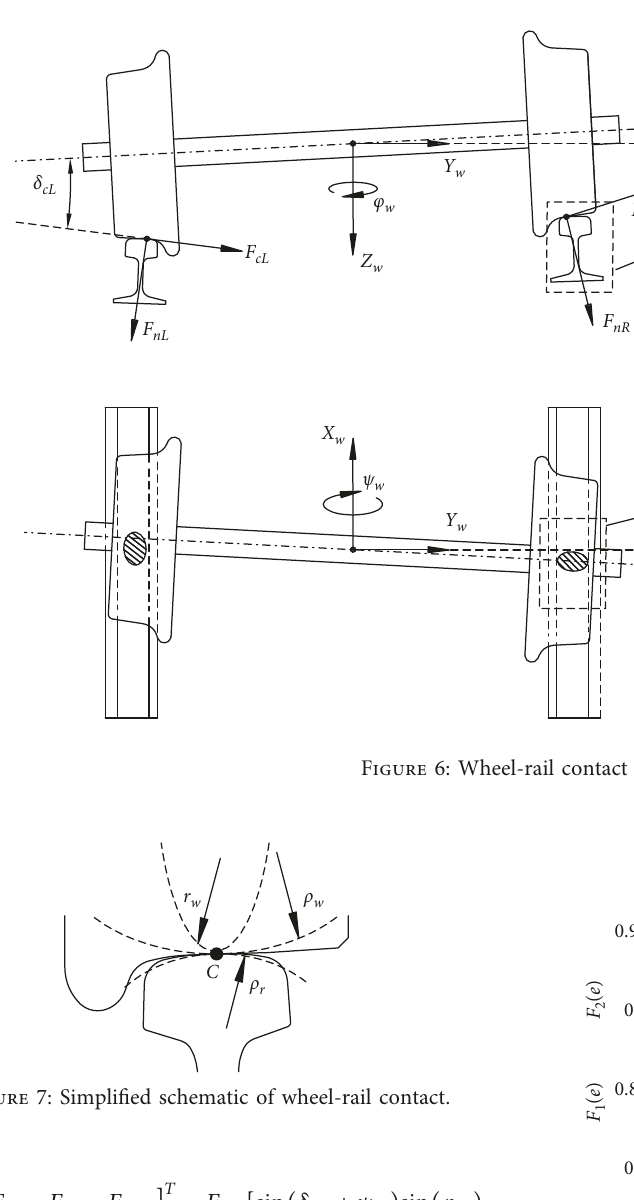
Figure 7: Simplified schematic of wheel-rail contact.